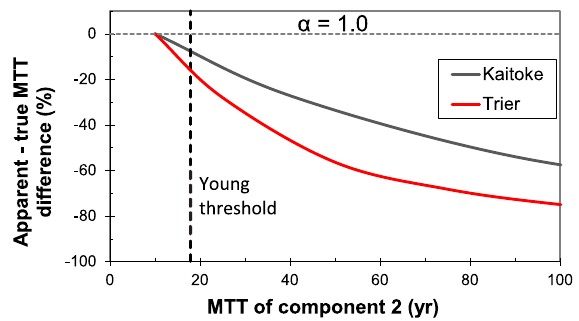
Figure 7. Comparison of maximum aggregation effects for South- ern Hemisphere (Kaitoke) and Northern Hemisphere (Trier) for the GM with α = 1. The curves show results with component 1 having mean transit time of 10 years (MTT1 = 10